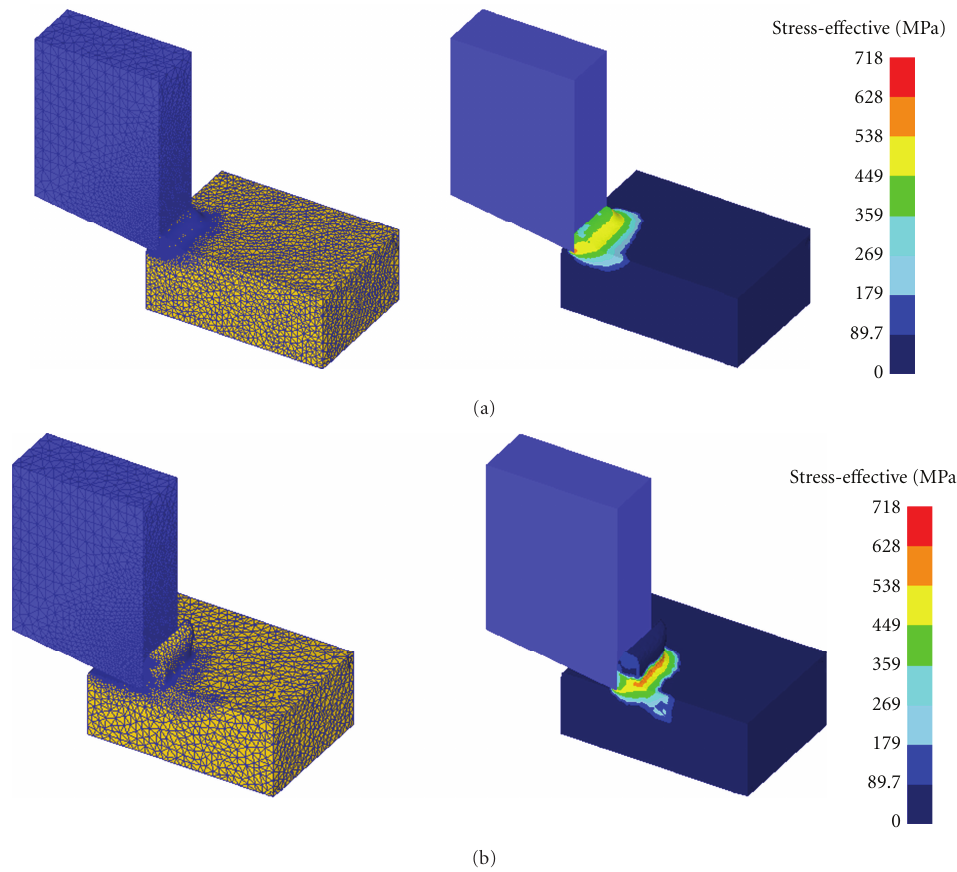
Figure 4: The history of the chip formation and the contour of e ff ective stress.